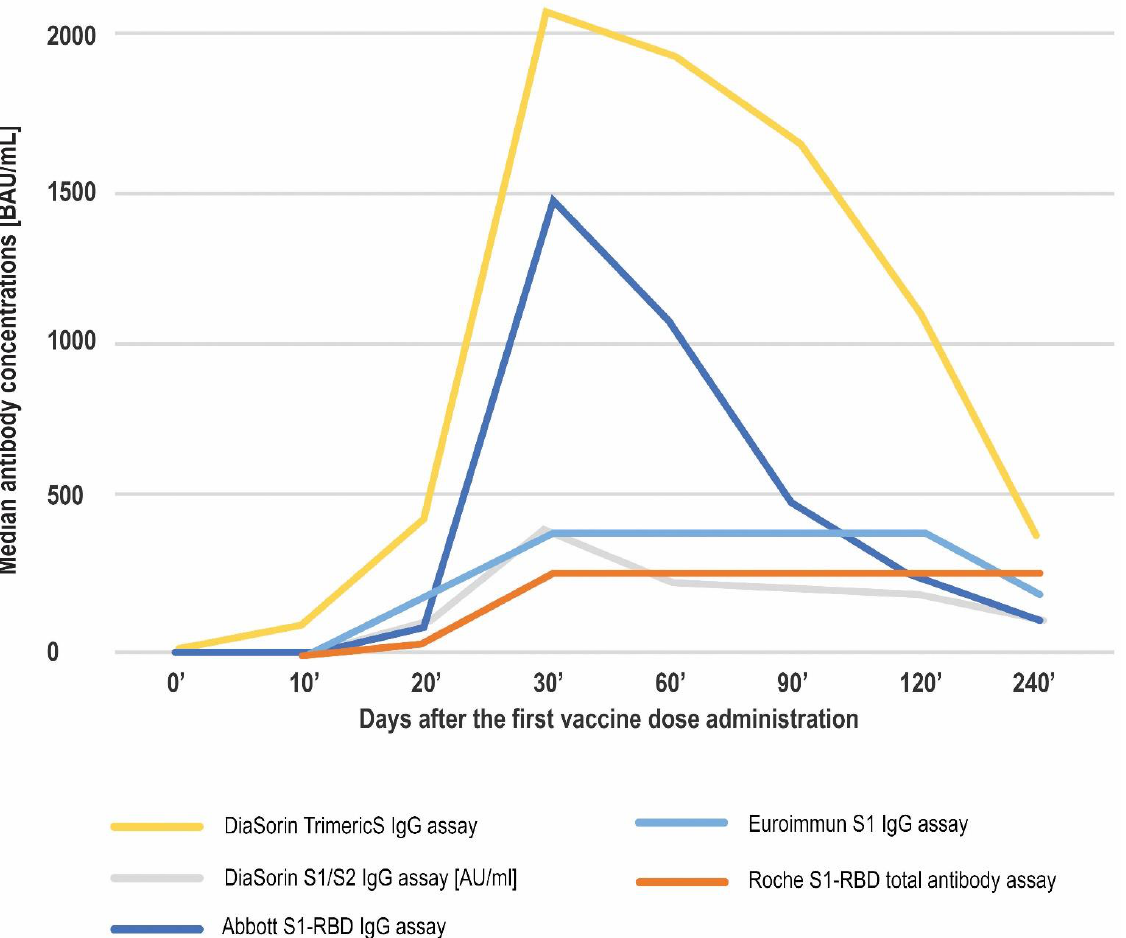
Figure 1. The course of anti-spike SARS-CoV-2 antibodies production over 8 months after the first vaccine dose administration. Apart from DiaSorin’s S1/S2 assay, which is expressed in AU/mL, the median concentrations are given in BAU/mL.